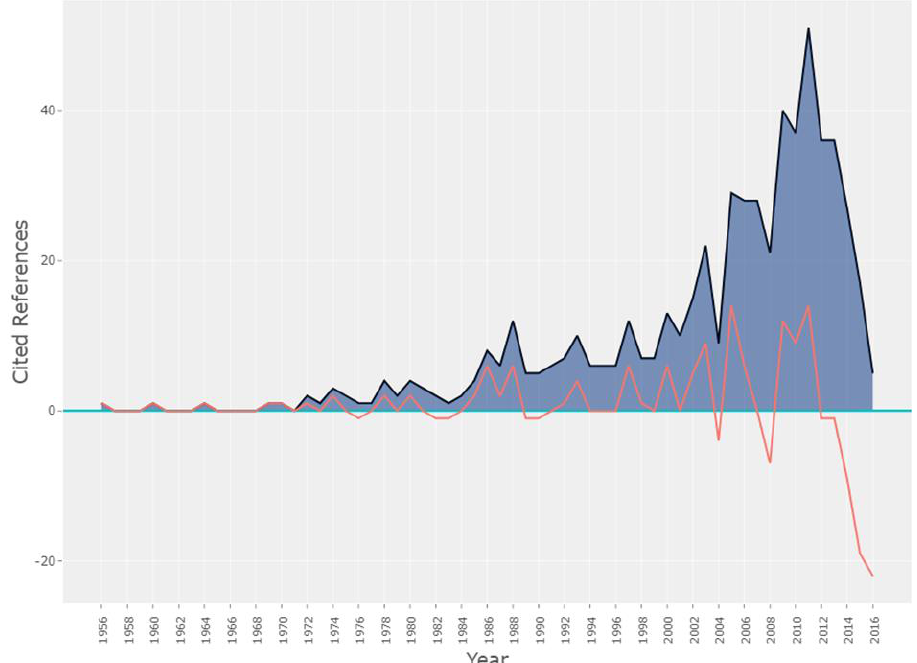
Figure 3. Spectroscopy analysis of the year of publication of the references.